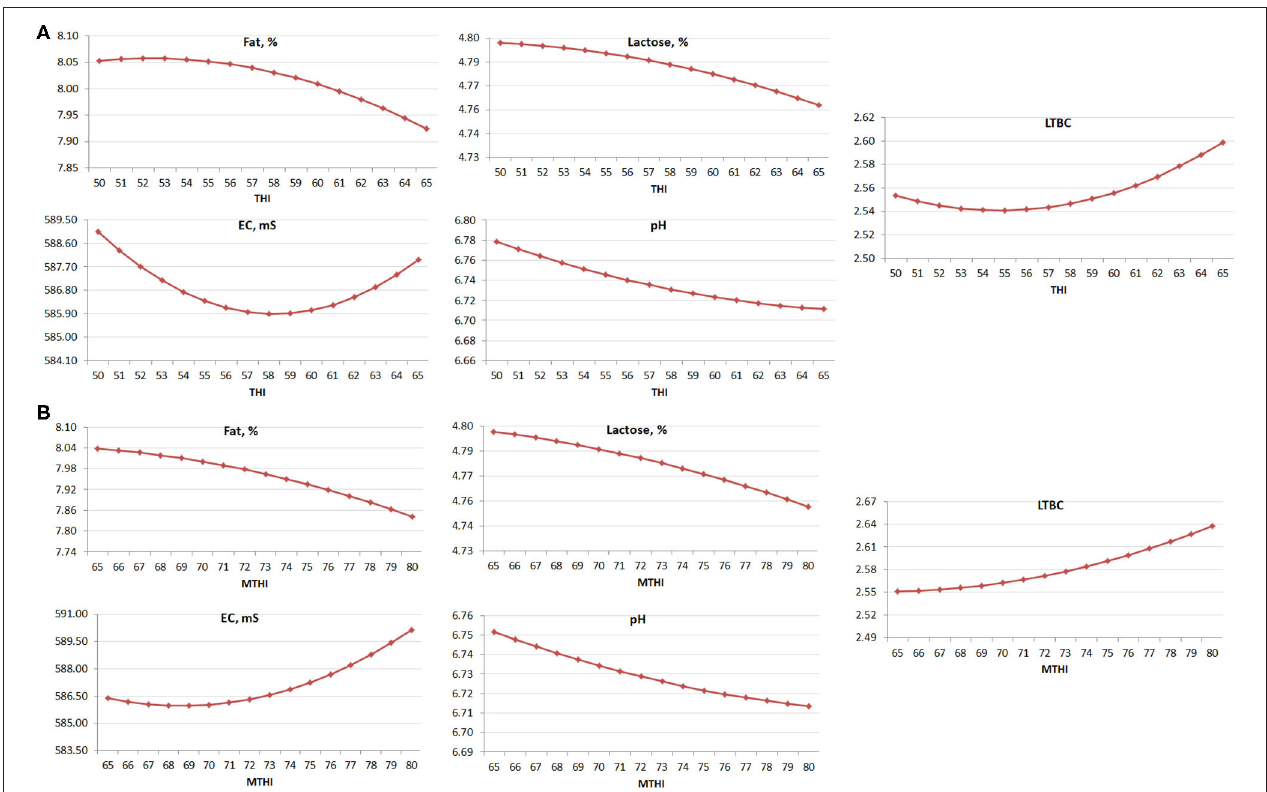
FIGURE 1 | Regression (linear + quadratic) of (A) THI and (B) MTHI on the studied milk traits ( P < 0.05).